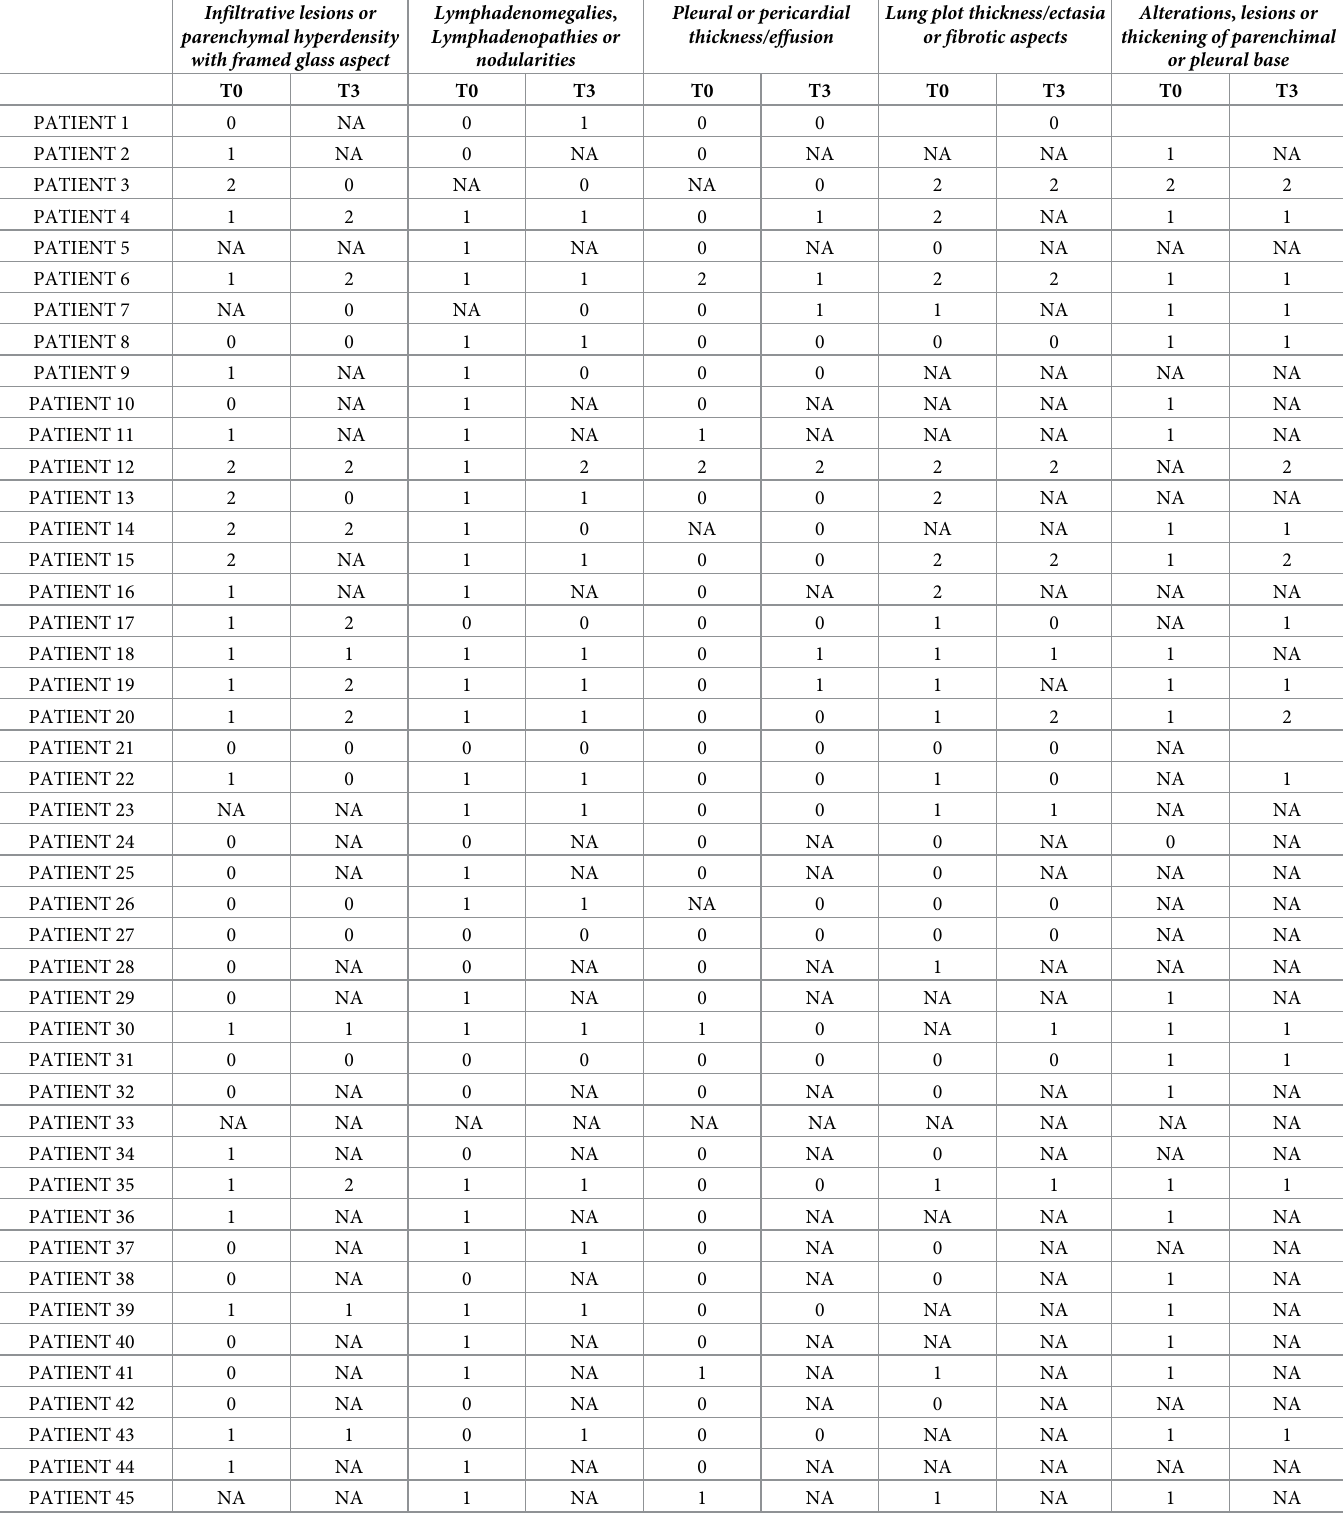
Table 2. Specific findings observed at Computed Tomography at baseline (T0) and after 3 months (T3) per each of the 75 hospitalized